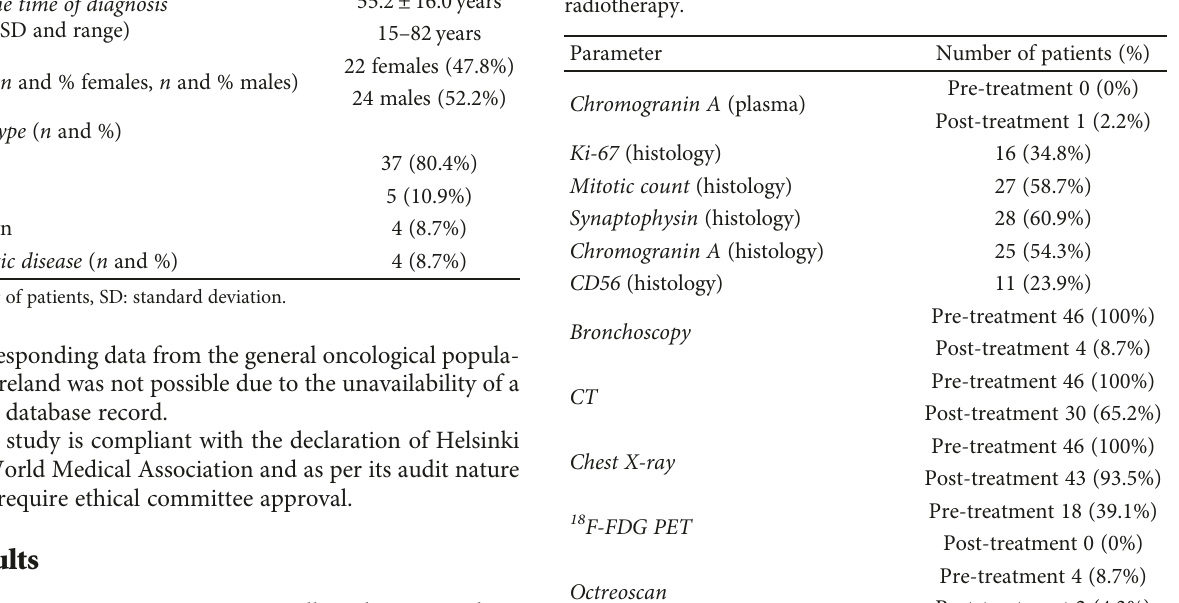
Table 2: Biochemistry, imaging, bronchoscopy, and pathology fi ndings in bronchial NET patients diagnosed, treated, or followed- up at our institution from 1 st January 1995 to 31 st December 2015 ( n = 46 ). Treatment refers to surgery, chemotherapy, or